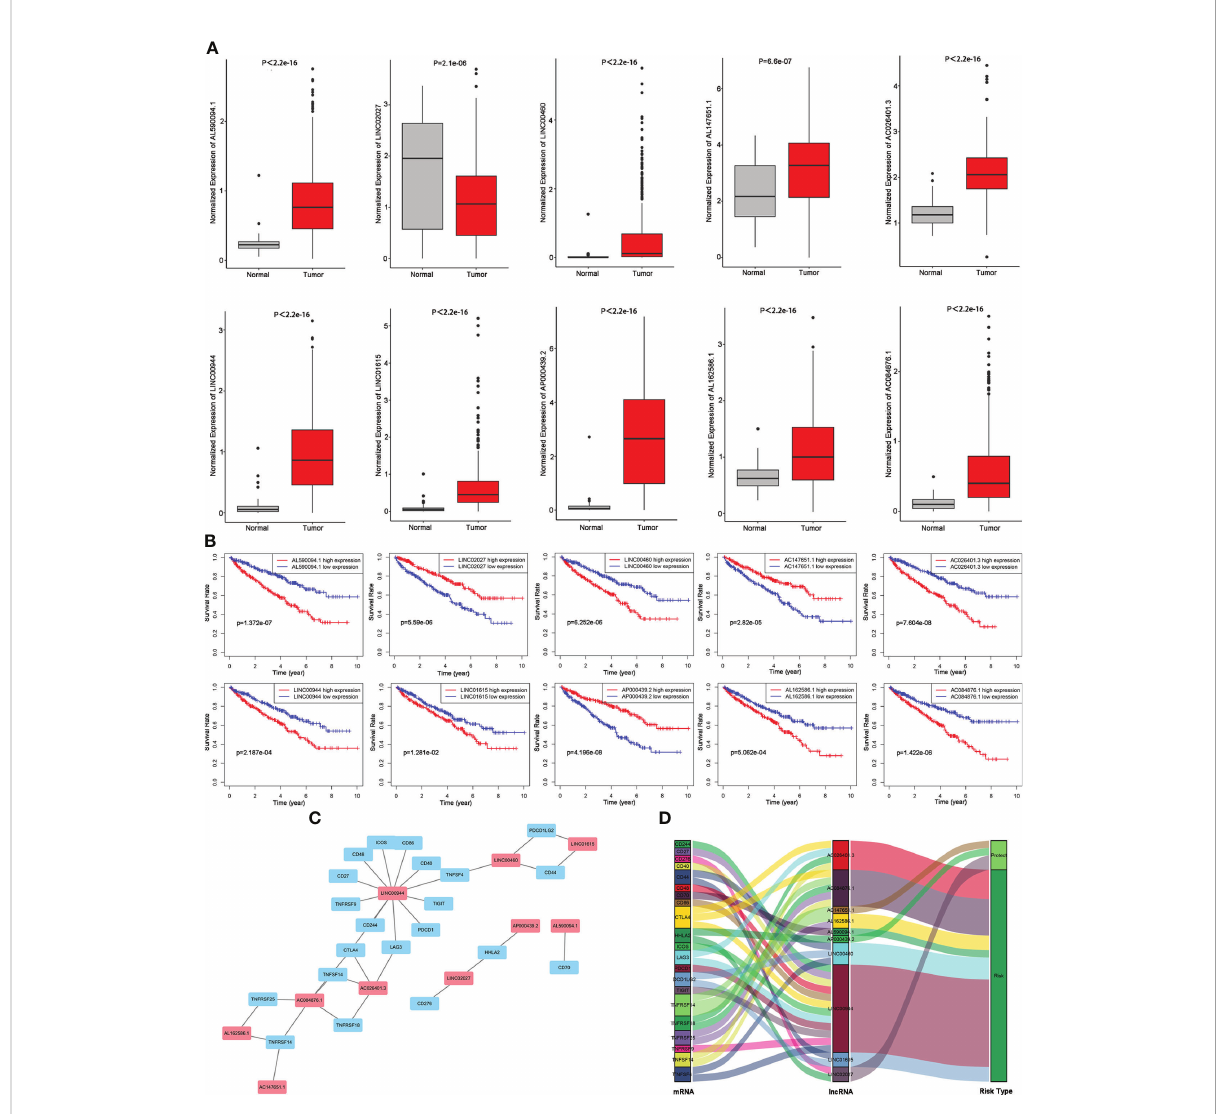
FIGURE 3 Evaluation of the 10 TIL-related lncRNAs. (A) Expression of the 10 TIL-related lncRNAs. (B) Prognostic value of the 10 TIL-related lncRNAs. (C) Coexpression network between prognostic lncRNAs and TIL-related genes. (D) Sankey diagram showing the association between prognostic TIL-related lncRNAs, TIL-related genes, and risk